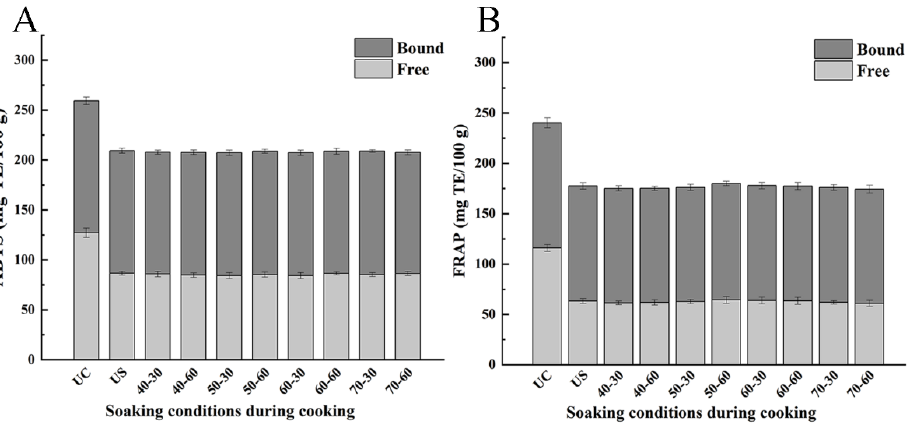
Figure 4. The antioxidant capacities determined by ABTS ( A ) and FRAP ( B ) assays of uncooked brown rice and cooked brown rice under different soaking conditions. Abbreviation was listed: UC (uncooked brown rice), US (unsoaked brown rice); soaking conditions such as “40-30” respected soaking at 40 °C for 30 min.